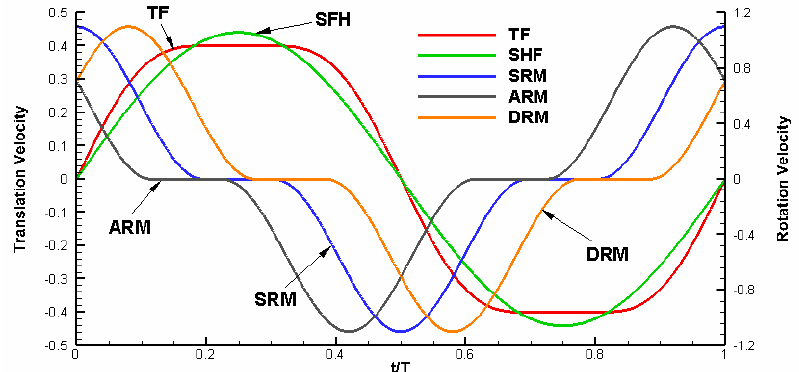
Figure 1. Non-dimensional translation (azimuthal rotation) velocity (left axis) and rotation velocity (right axis) in one cycle. (SHF: simple harmonic function; TF, trapezoidal function [5]; SRM: symmetrical rotation mode; ARM: advanced rotation mode; DRM: delayed rotation mode).